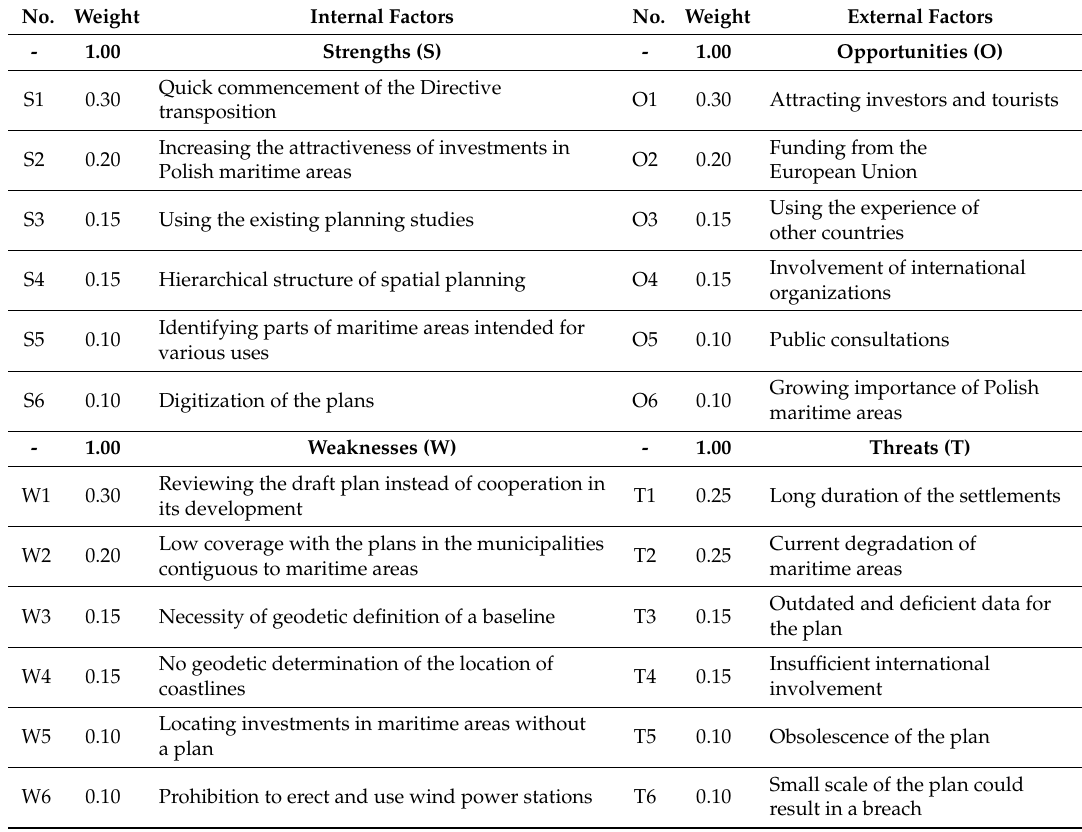
Table 6. Factors of the analysis. Source: own